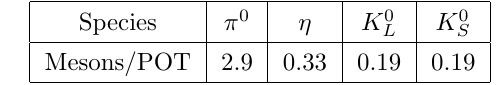
Table 5 . Average number of neutral mesons produced per proton-on-target assuming 120 GeV